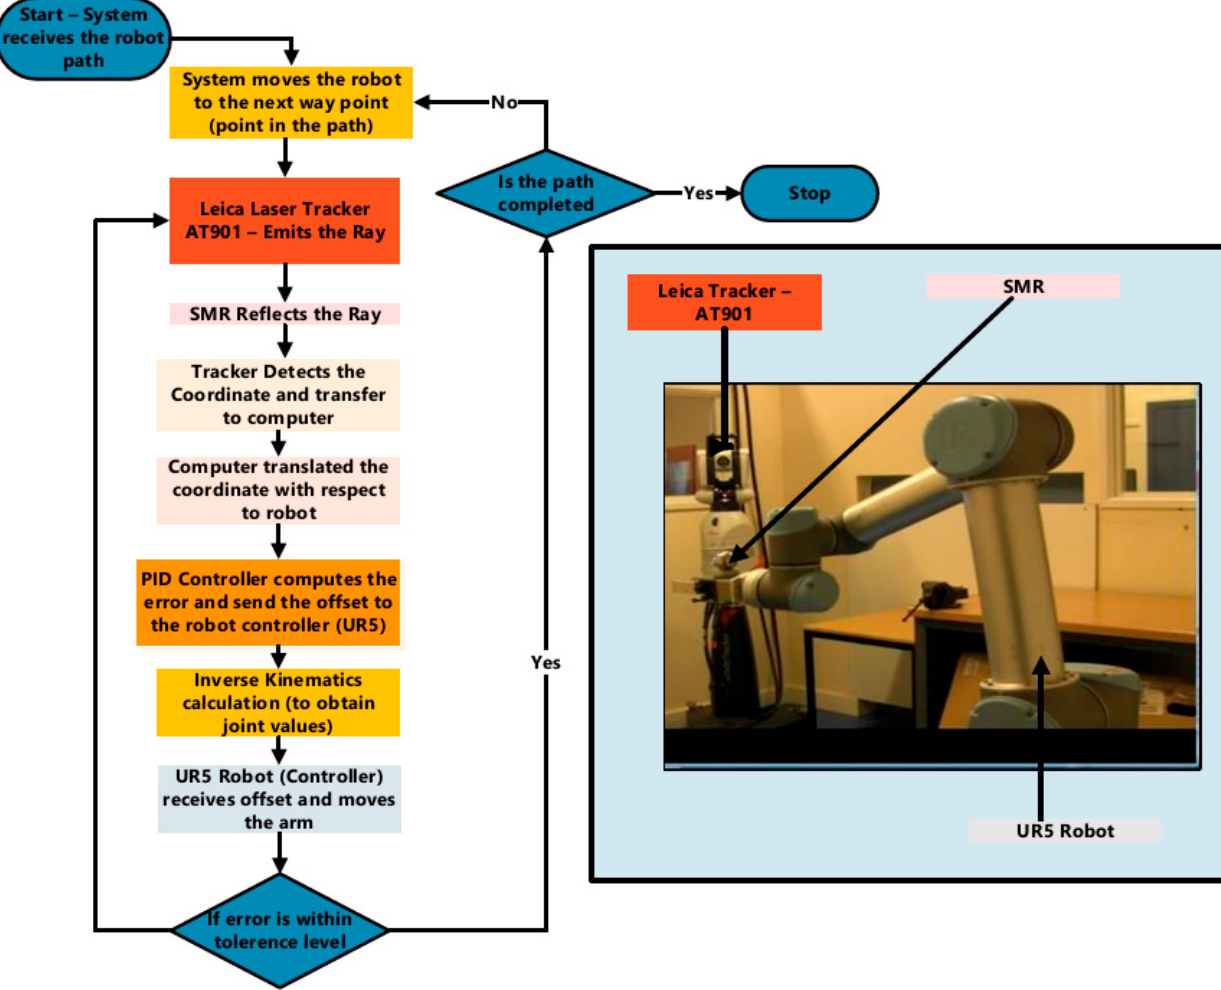
Figure 3. Small-scale system flow chart ( Left ) and physical cell ( Right ).